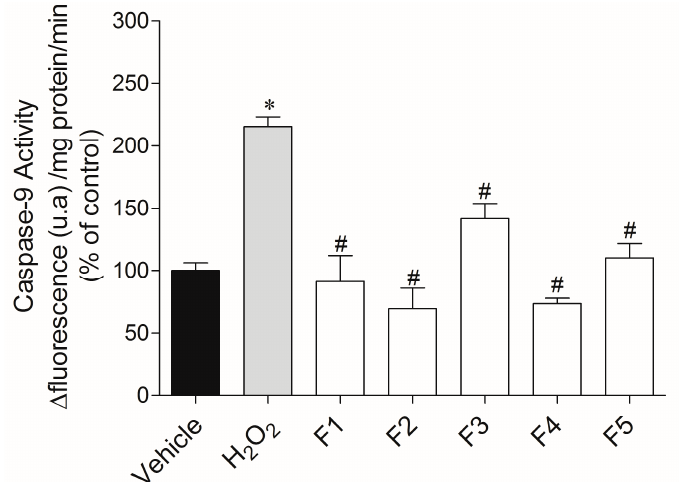
Figure 5. H 2 O 2 (0.2 mM) effects on caspase-9 activity of MCF-7 cells in the presence or absence of Fucus spiralis fractions (1 mg/mL) after 24 h of treatment. The activity was quantified by the slope of the linear phase accumulation of 7-amino-4-(trifluoromethyl) coumarin (between 25 and 75 min). The results are presented in arbitrary units of fluorescence per mg of protein (% of control). The values in each column represent the mean ± standard error of the mean (SEM) from three independent experiments. Symbols represent statistically significant differences ( p < 0.05, ANOVA, Dunett’s test) when compared to: * vehicle and # to H 2 O 2 .